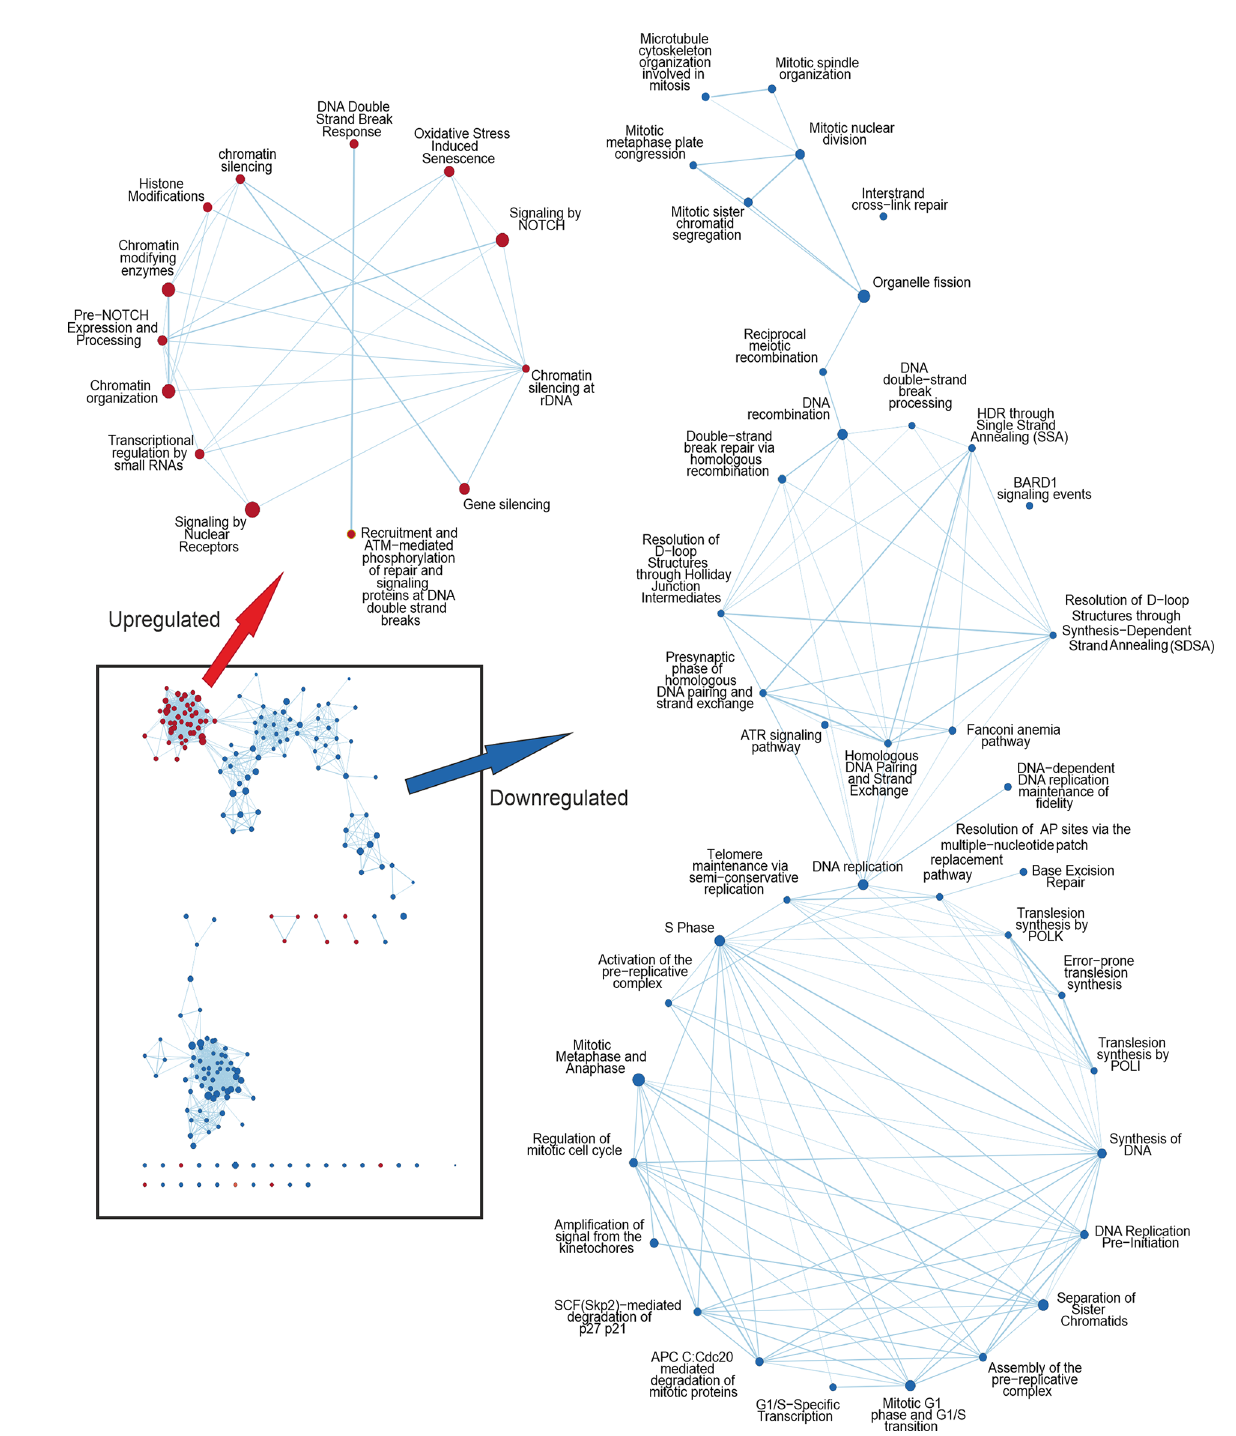
FIGURE 2 | Cytoscape network analysis of the enriched pathways in IMX compared to MX indicating the effect of IM. Upregulated nodes in IMX are shown in red and downregulated nodes in blue. Lower left box represents the most signi fi cant nodes. Arrows depict the magni fi cation of nodes fi ltered with diffusion algorithm. Pathways related to DNA damage response are upregulated, whereas pathways related to cell cycle progression and mitosis are downregulated. In the middle cluster of the downregulated nodes are pathways related to homologous recombination and ATR signalling.